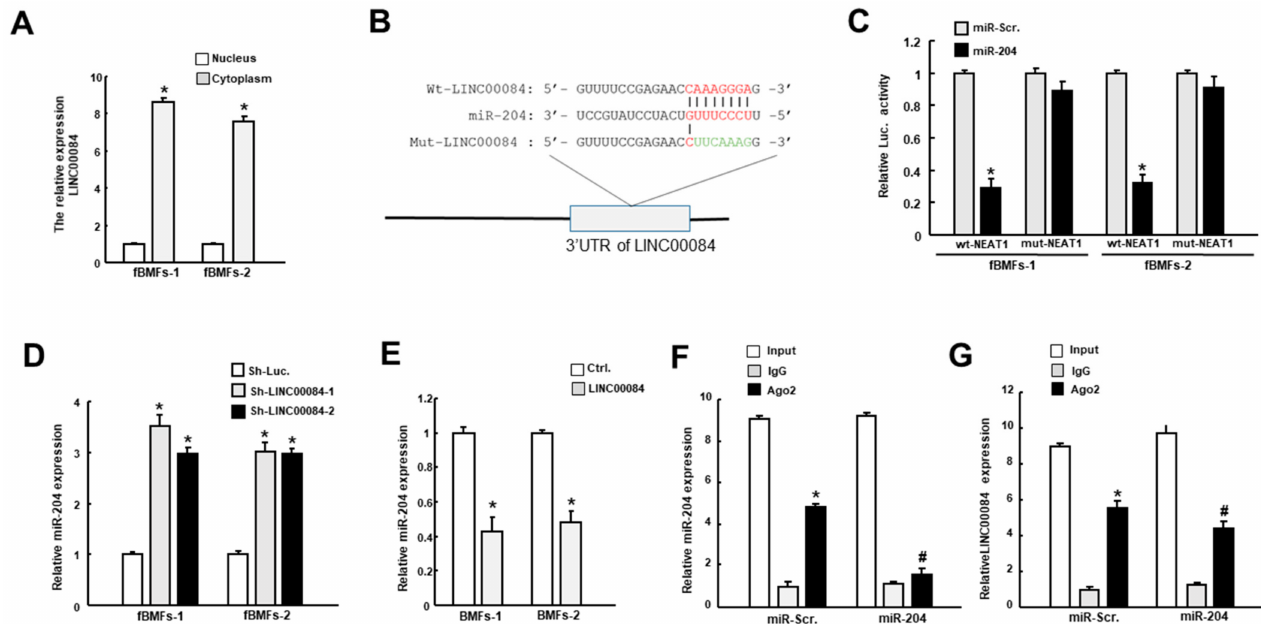
Figure 4. LINC00084 curbs the expression of miR-204 in fBMFs. ( A ) The relative cytoplasmic and nuclear levels of LINC00084 in fBMFs analyzed by qRT-PCR. * p < 0.05 compared to the nucleus group; ( B ) schematic representation of the alignment of the LINC00084 base pairing with miR-204. Wild-type (Wt) and mutated (Mut) LINC00084 reporter plasmids were co-transfected with miR-204 or empty vectors (miR-Scr.); ( C ) the relative luciferase activity of each combination in two fBMFs was assessed and only WT reporter activity was suppressed by miR-204; ( D ) the relative expression of miR-204 in two fBMFs transfected with sh-Luc. or sh- LINC00084; ( E ) the expression level of miR-204 in two LINC00084-overexpressing fBMFs; ( F ) enrichment of miR-204 ( F ) or LINC00084 ( G ) relative to input was assessed via the RIP experiment using anti-Ago2 in fBMFs transfected with miR-Scr. or miR-204 inhibitor with anti-IgG as a negative control. The relative expression levels of miR-204 and LINC00084 were detected by qPCR * p < 0.05 compared to sh-Luc. or control group; # p < 0.05 compared to miR-Scr.